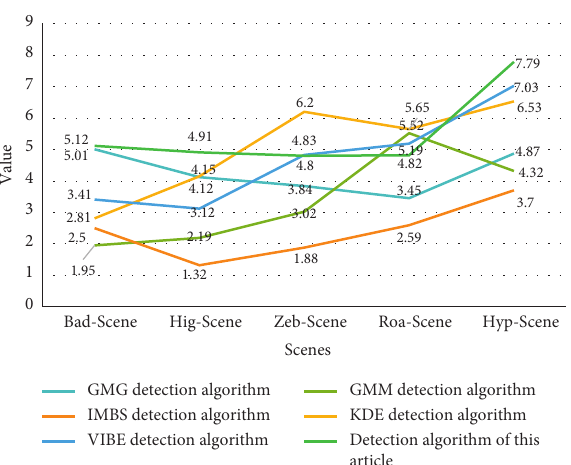
Figure 5: Effect analysis diagram of camera shake video library